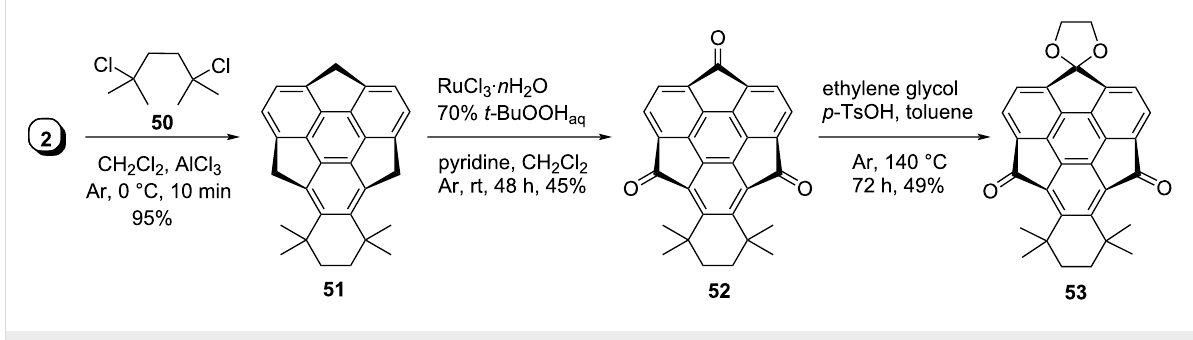
Scheme 11: Synthesis of sumanene building block 53 useful for further extension.